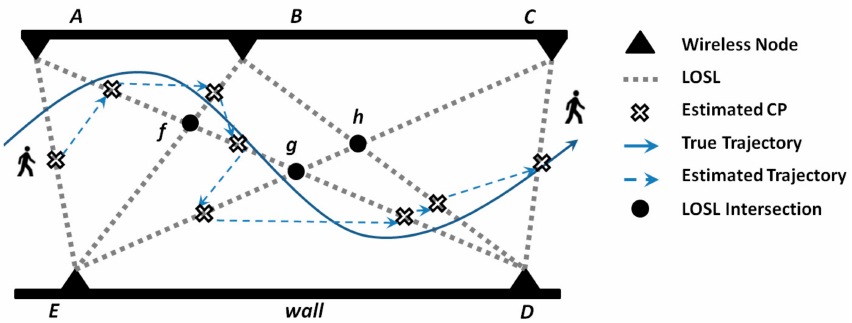
Figure 3. A scenario for the CP estimation of the LOSLs according to triggering sequence and time